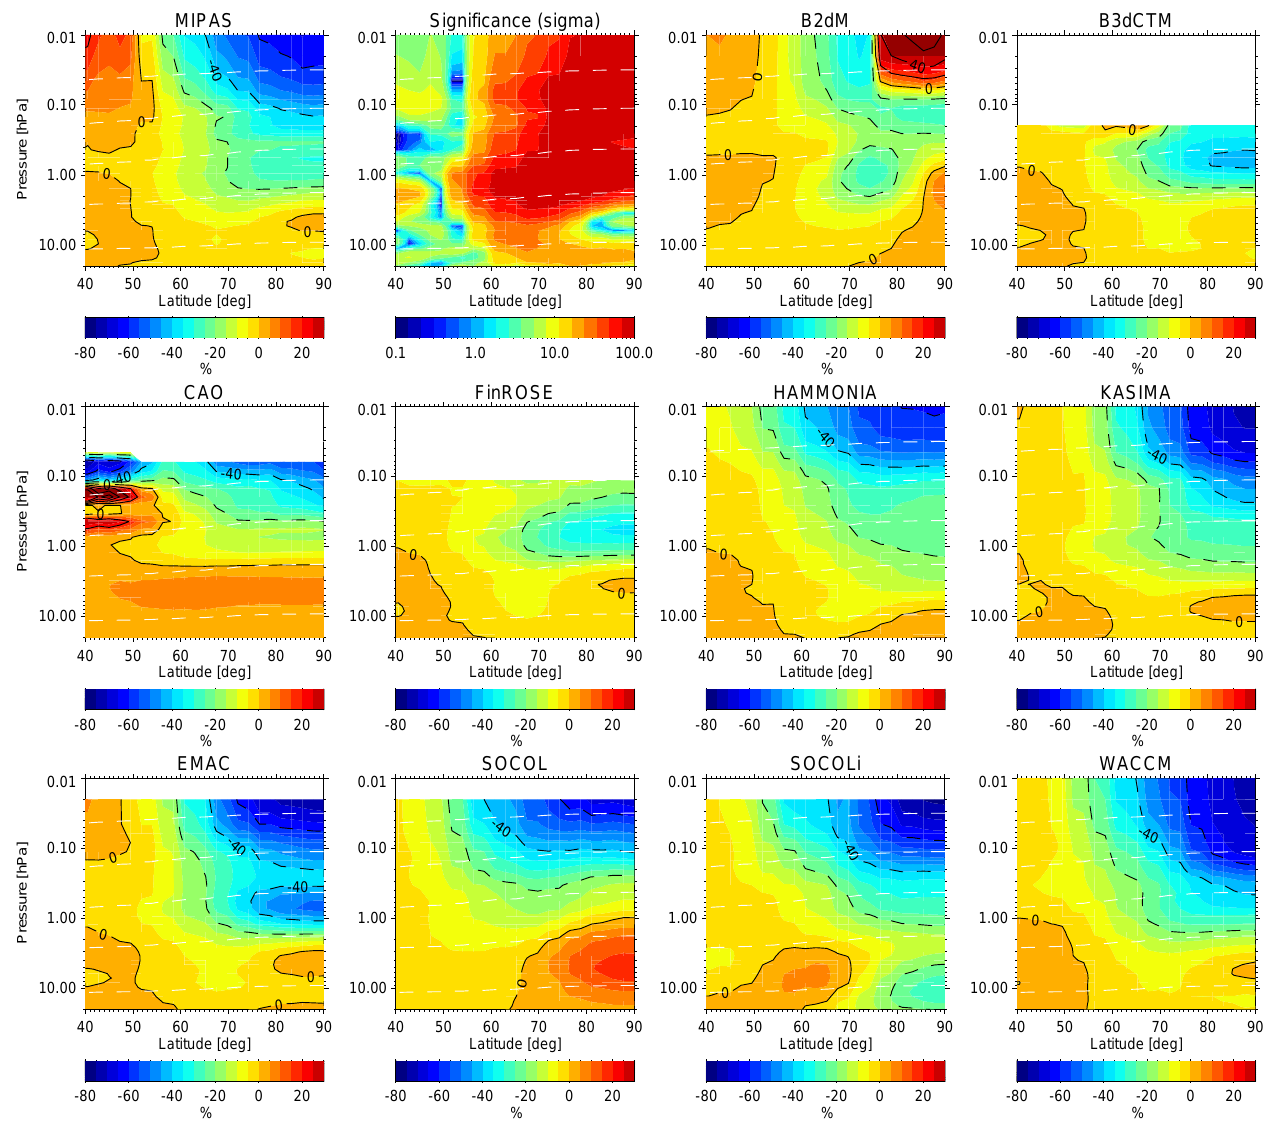
Fig. 28. Zonal mean relative O 3 changes with respect to 26 October averaged over the period 28 October–4 November in MIPAS observations and model simulations. Solid contour lines reflect 20% steps. The significance of the observations is also shown (second top panel from the left, in units of σ ).